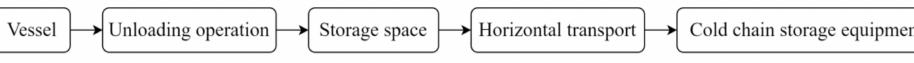
Figure 2. Flow chart of logistics process in